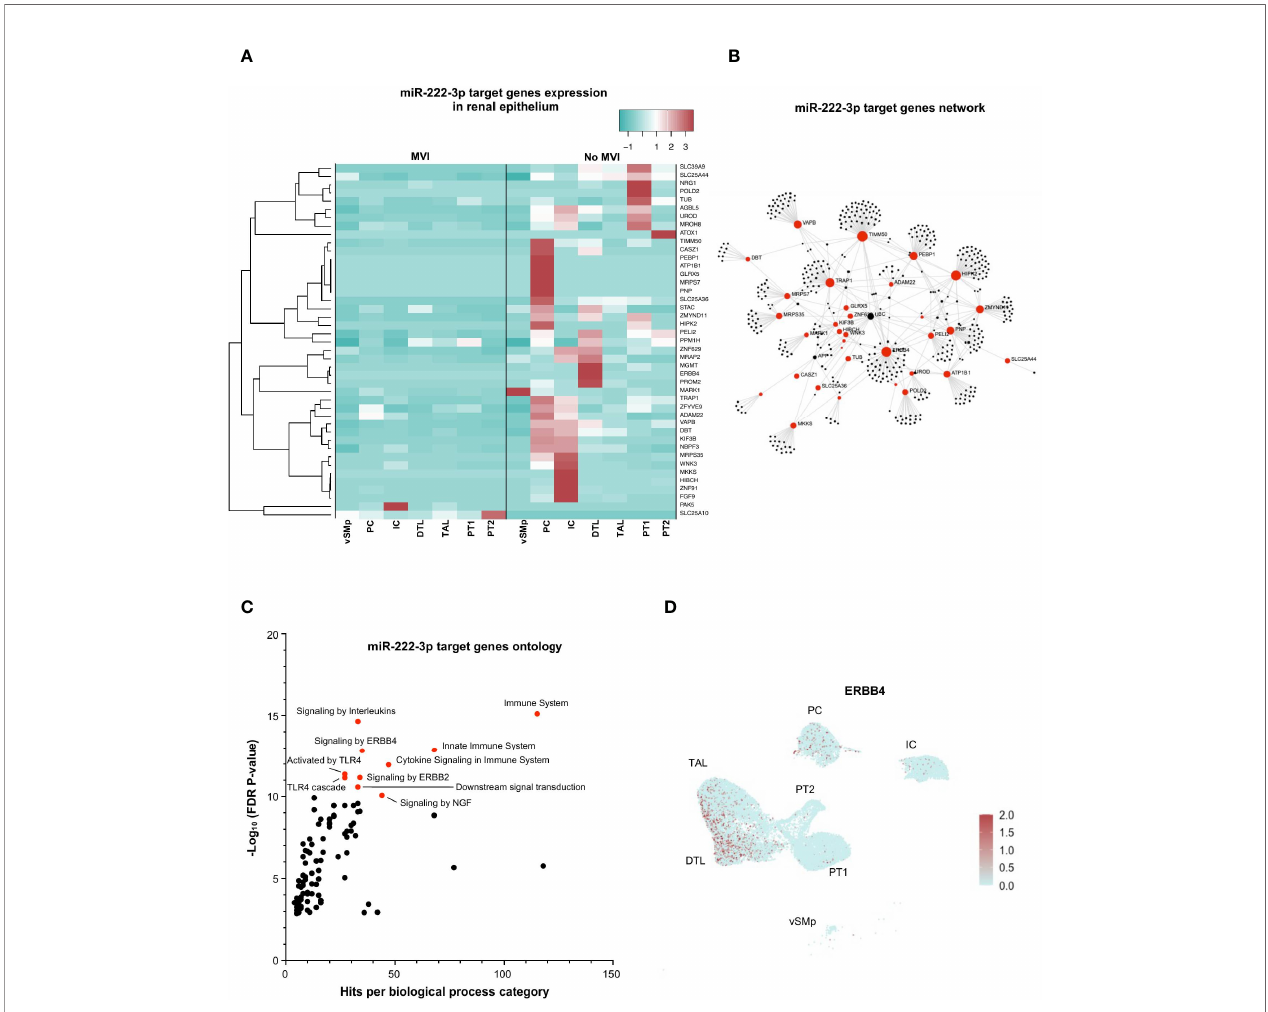
FIGURE 6 | miR-222-3p impairs both renal physiological and immune-related pathways in epithelial cells during MVI. (A) Heatmap showing the expression of each individual miR-222-3p target genes in the different epithelial subsets and according to the MVI groups. (B) Gene network corresponding to the 43 downregulated genes in MVI genes built on Omicsnet. (C) Gene ontology and pathway enrichment analysis based on Omicsnet and Reactome databases. The name of the top 10 enriched pathways in term of adjusted P-value are shown (red dots). (D) UMAP showing a diffuse ERBB4 expression in all renal epithelial sc-RNAseq cell clusters. DTL, descending thick limb cells; IC, intercalated cells; PC, principal cells; PT, proximal tubular cells; TAL, thick ascending limb cells; UMAP, Uniform manifold approximation and projection; vSMp, vascular smooth muscle and